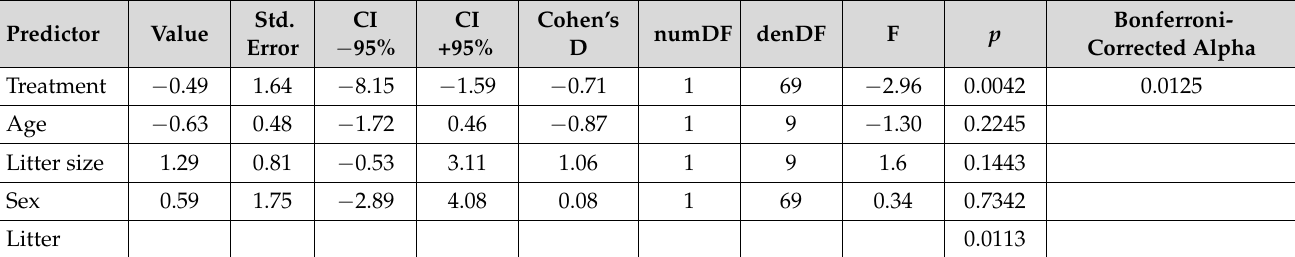
Table 8. Results of the linear mixed-effects model assessing the effect of treatment, age, litter size, and sex on “PC 1—Social-Startle”. The p -value for litter refers to the ANOVA comparing the models with and without litter included. “Bonferroni-corrected α for treatment” indicates the alpha level (after sequential Bonferroni correction) to determine whether the treatment effect was